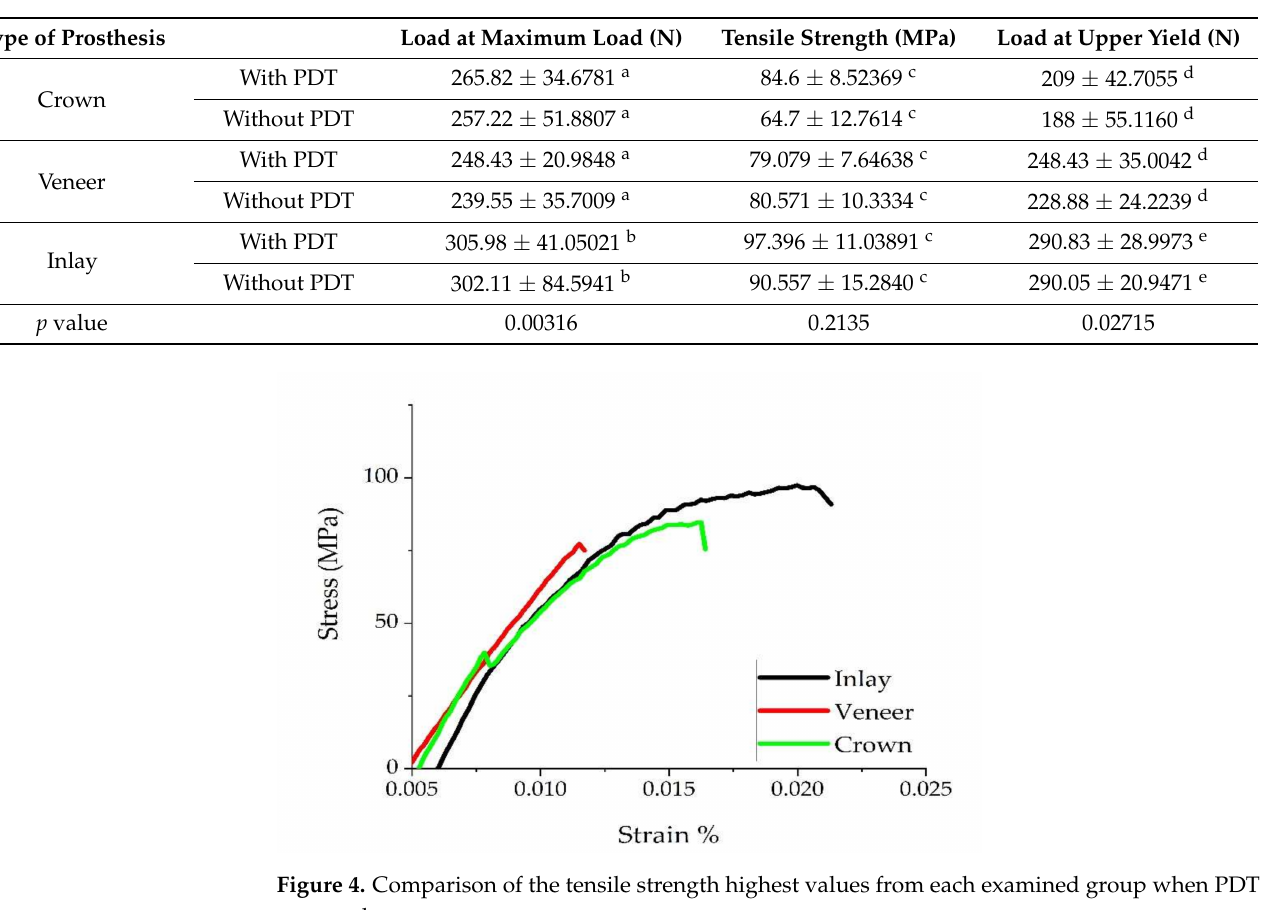
Table 1. Adhesion pull-out test.